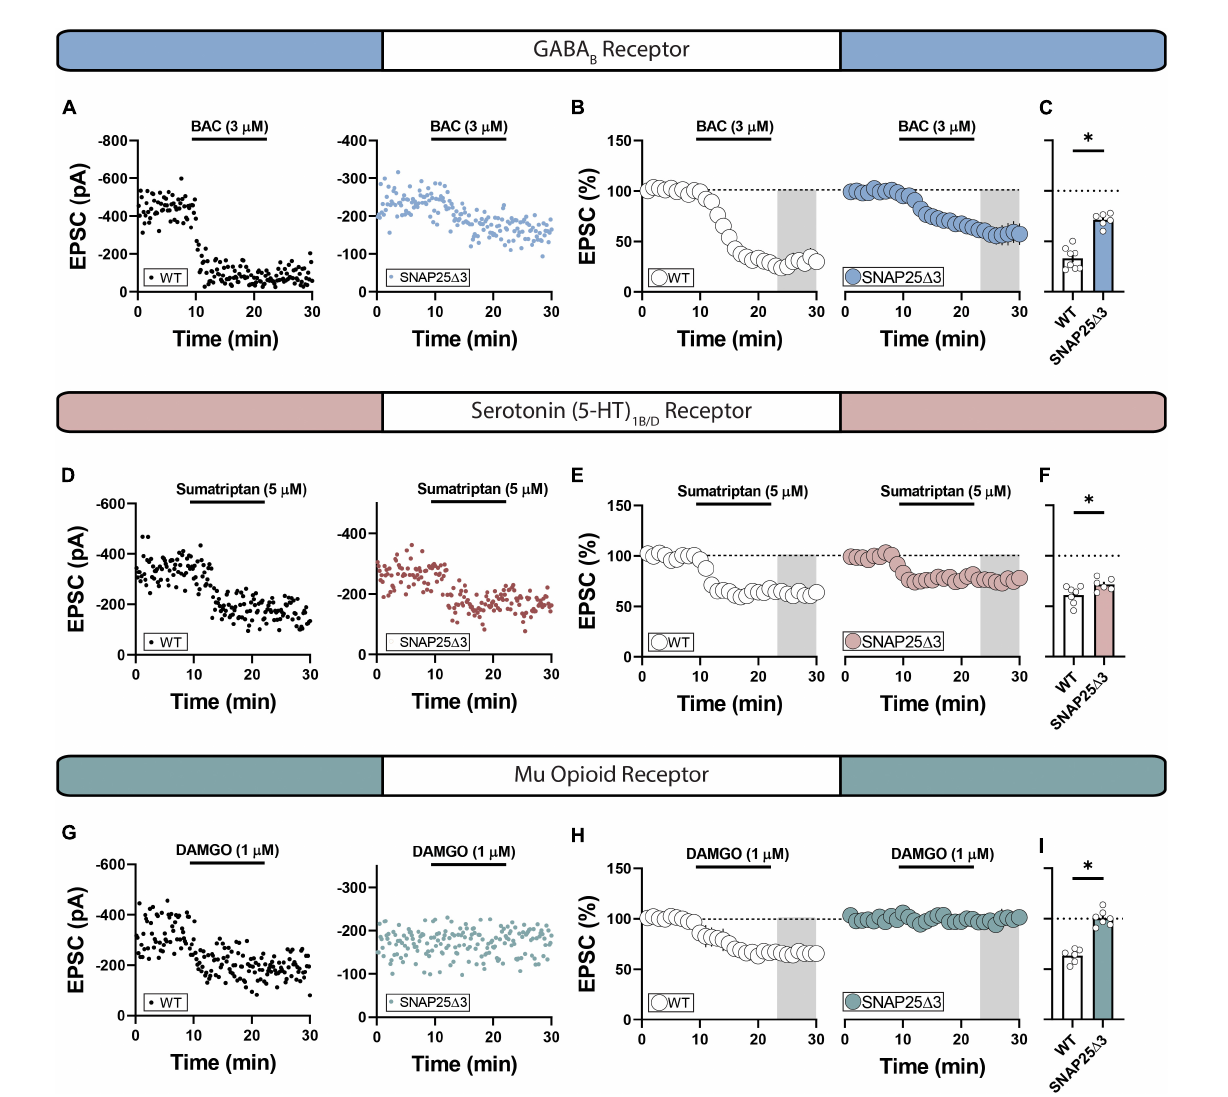
FIGURE2 SNAP25 (cid:49) 3 attenuates G i / o -coupled GPCR induced depression of excitatory transmission in select GPCR systems. (A) Representative experiments showcasing amplitude peaks of EPSCs following bath application of GABAB receptor agonist baclofen (BAC: final concentration = 3 uM) collected from WT and SNAP25 (cid:49) 3 mice. (B) Percentage changes in EPSC peak amplitude with regards to baseline following BAC application (application time: 10–20 min). (C) Summary of average EPSC percentages following BAC application (time = 25–30 min; WT: mean = 33.01 ± 3.77%; SNAP25 (cid:49) 3: mean = 71.27 ± 2.72%; p = < 0.0001). [WT: n = 8 cells; SNAP25 (cid:49) 3: n = 6 cells]. (D) Representative experiments showcasing amplitude peaks of EPSCs following bath application of 5-HT1B/D receptor agonist sumatriptan (sumatriptan: final concentration = 5 uM) collected from WT and SNAP25 (cid:49) 3 mice. (E) Percentage changes in EPSC peak amplitude with regards to baseline following sumatriptan application (application time: 10–20 min). (F) Summary of average EPSC percentages following sumatriptan application (time = 25–30 min; WT: mean 61.16 ± 3.42%; SNAP25 (cid:49) 3: mean = 71.59 ± 2.52%; p = 0.0362). [WT: n = 7 cells; SNAP25 (cid:49) 3: n = 6 cells]. (G) Representative experiments showcasing amplitude peaks of EPSCs following bath application of Mu-opioid receptor agonist DAMGO (final concentration = 5 uM) collected from WT and SNAP25 (cid:49) 3 mice. (H) Percentage changes in EPSC peak amplitude with regards to baseline following DAMGO application (application time: 10–20 min). (I) Summary of average EPSC percentages following DAMGO application (time = 25–30 min; WT: mean 63.15 ± 2.79%; SNAP25 (cid:49) 3: mean = 100.3 ± 2.90%; p = < 0.0001). [WT: n = 6 cells; SNAP25 (cid:49) 3: n = 7 cells]. Gray box indicates 5-min bin for comparative analysis. Error bars indicate SEM. ∗ p < 0.05. Student’s unpaired, two-tailed, t